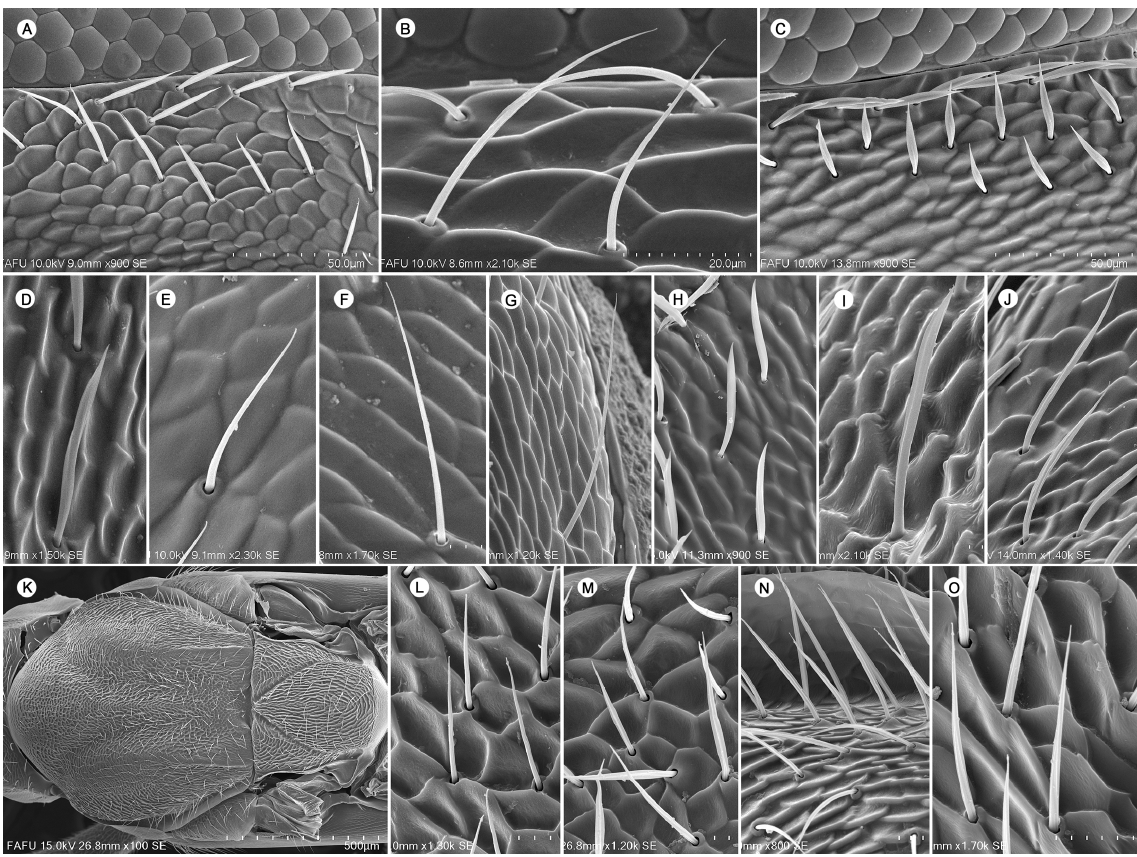
Fig. 8. SEM photos. A‒C . Parascrobal region, show sculpture and setae. A . Zaischnopsis covid Jiang